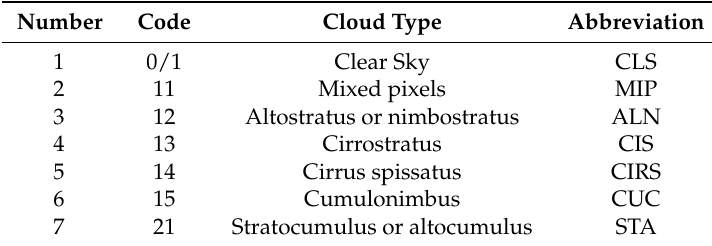
Table 2. FengYun-2D (FY-2D) cloud classification codes and cloud